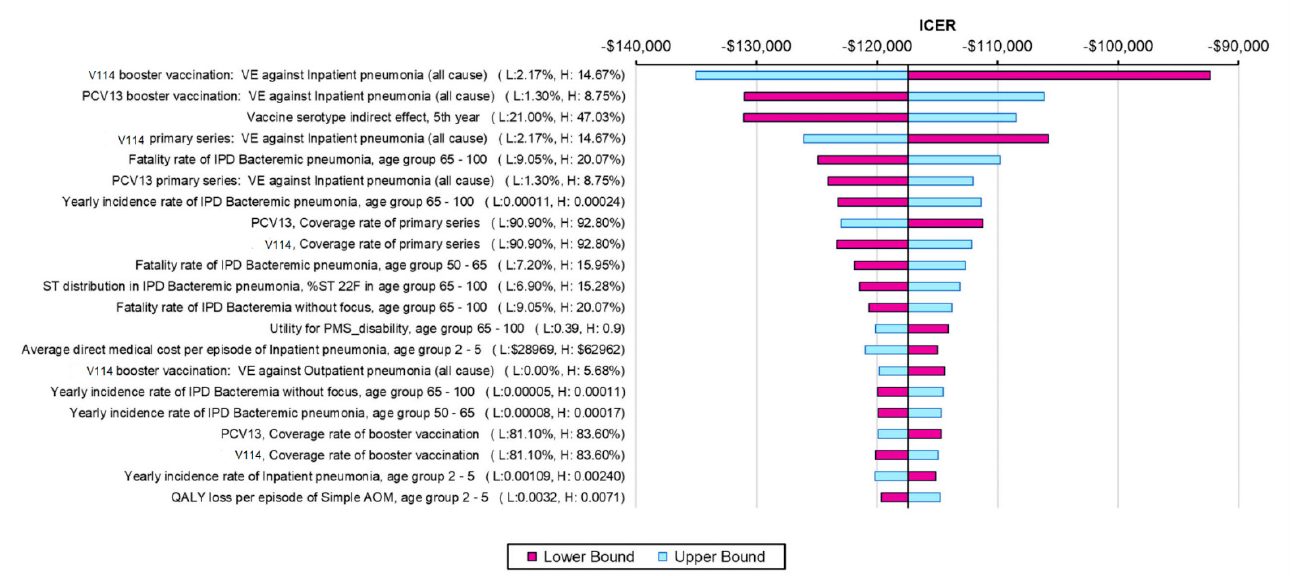
Figure 2. One-way sensitivity analysis results (showing the most impactful parameters). Abbre- viations: ICER = incremental cost-effectiveness ratio; PCV13 = 13-valent pneumococcal conjugate vaccine; V114 = 15-valent pneumococcal conjugate vaccine; VE = vaccine effectiveness; IPD = invasive pneumococcal disease; AOM = acute otitis media; ST = serotype; QALY = quality-adjusted life year. Notes: Tornado diagram showing the results of the one-way sensitivity analysis. The purple bars show the change in ICER from the base case when the higher value of an input was used whereas the light blue bars show the change in ICER from the base case when the lower value of the selected input was used while all other inputs remain constant.